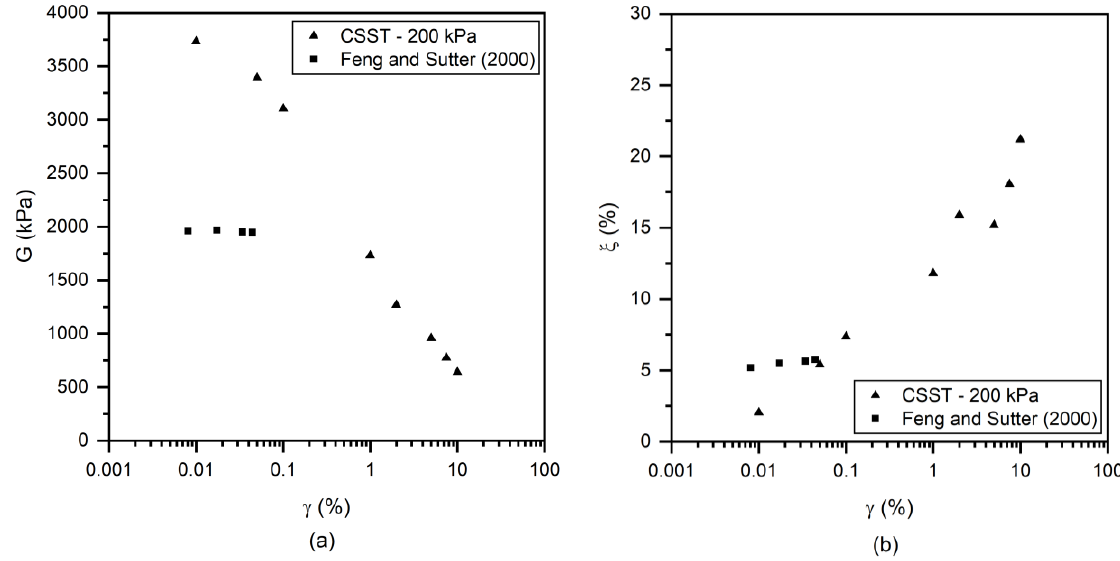
Figure 9. Comparisons between the ( a ) shear moduli and ( b ) damping ratios of CSSTs and Feng and Sutter [21].